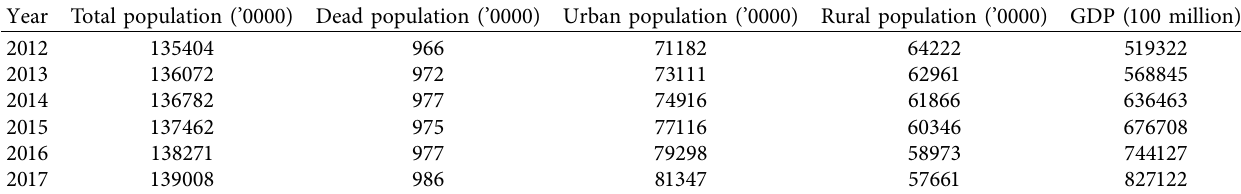
Table 1: General overview of Chinese Society.